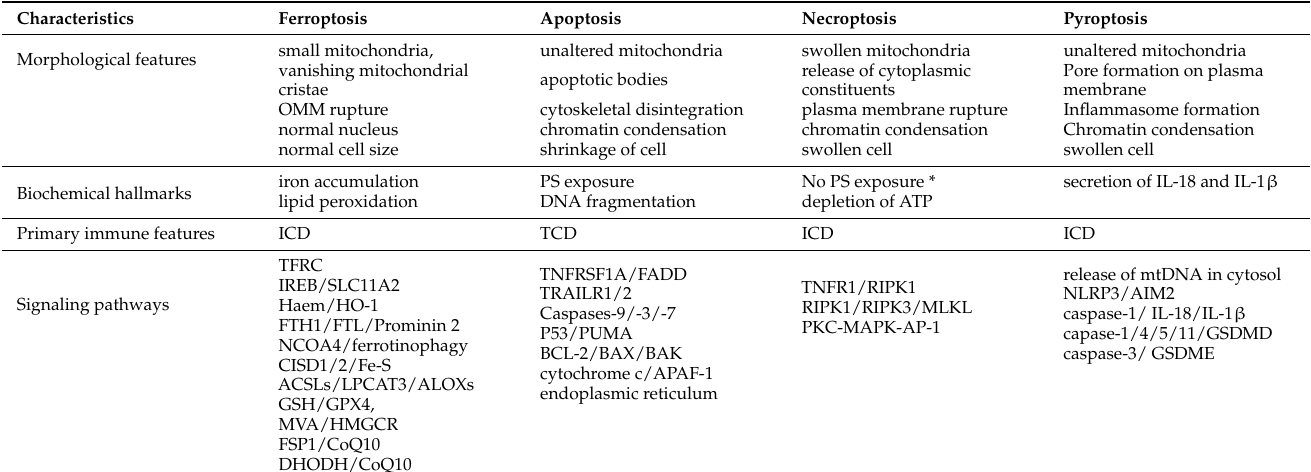
Table 1. Characteristics of ferroptosis, apoptosis, necroptosis, and